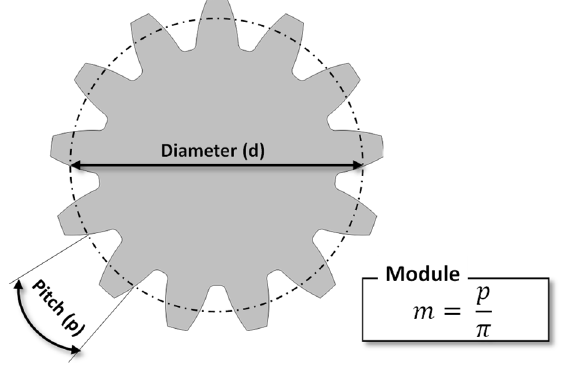
Figure 1. Characteristic gear parameters.